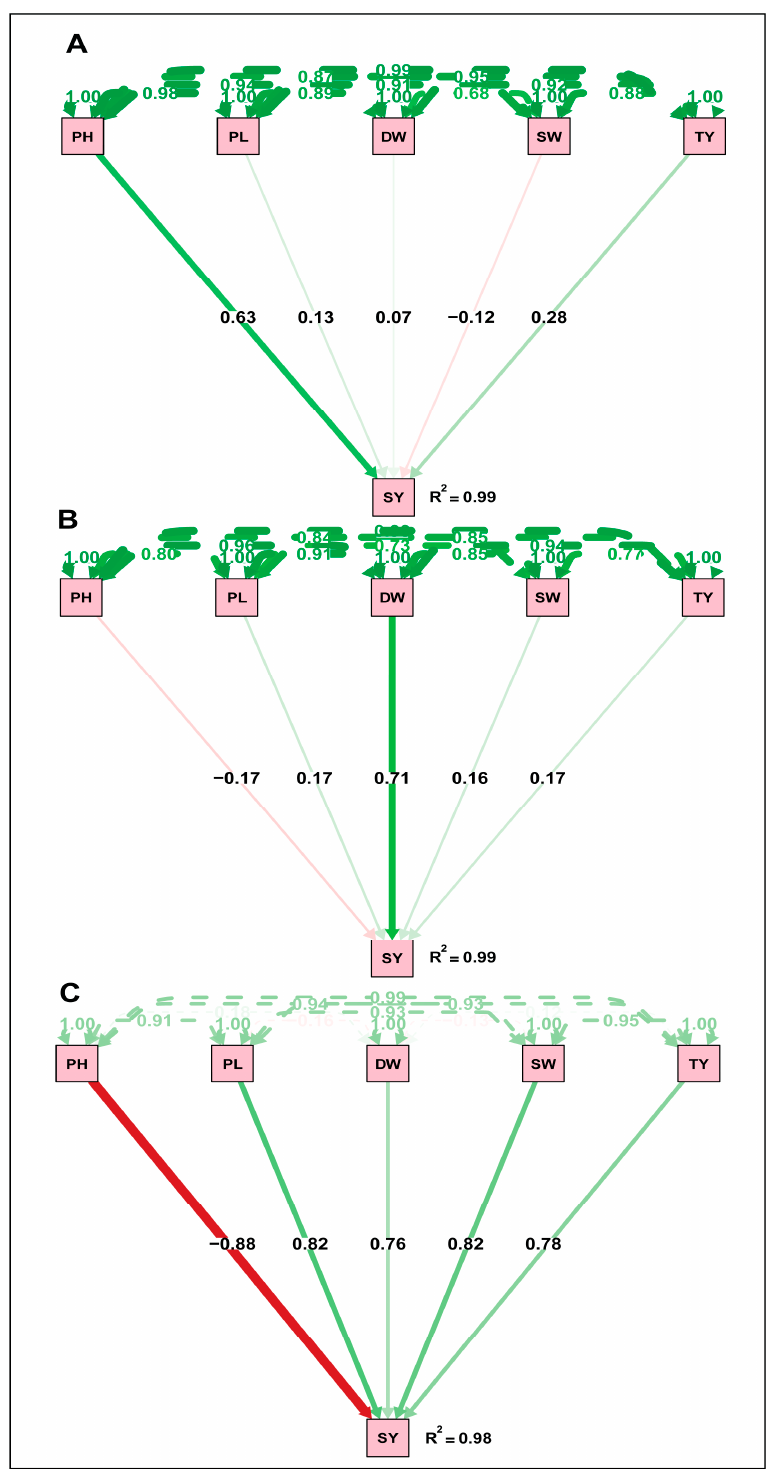
Figure 5. Path analysis diagram showing the interrelationships between seed yield (response variable) and other studied traits under three water regimes: 100% ( A ), 80% ( B ), and 60% ETc ( C ). Bidirectional arrows show the correlation between the variables and single-headed arrows indicate direct path coefficients; green and red arrows represent positive and negative effects, respectively. Solid arrows indicate P < 0.05. PH: plant height (cm); EL: panicle length (cm); DW: dry weight (g); SW: seed weight (g); SY: seed yield (t/ha); TY: total yield (t/ha).